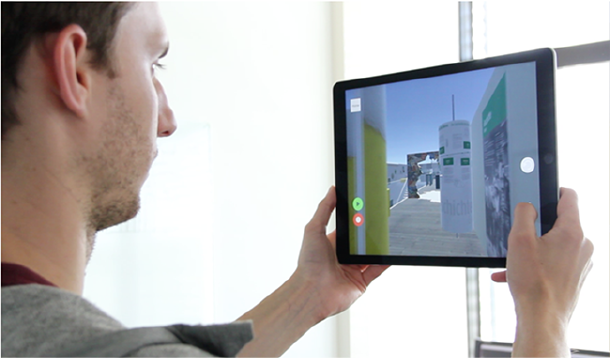
Figure 5. The tablet camera